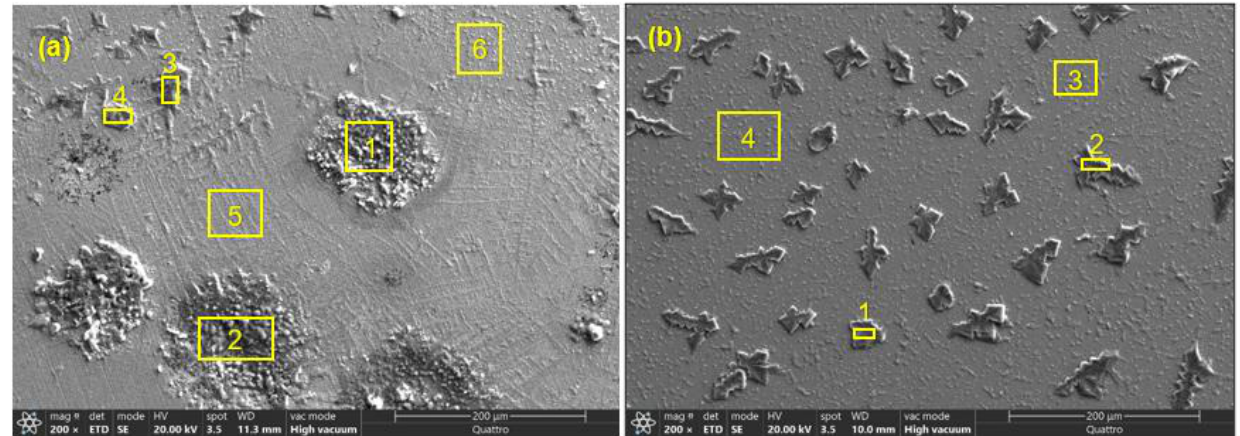
Figure 9. SEM image after potentiodynamic polarization measurements for ( a ) AISI 304L and ( b ) AISI 316L in seawater with 40 ppm S 2 − ions at 298 K with marked parts of EDS analysis (yellow numbers). Table 7. Elemental composition on marked parts of the surface of AISI 304L and AISI 316L steels after impedance measurements in seawater with 40 ppm S 2 − ions at 298 K. AISI